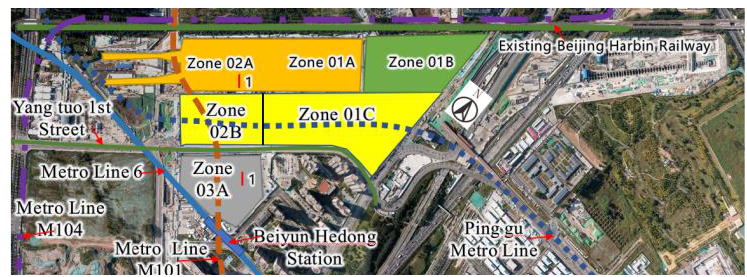
Figure 1. Plan view of construction environment.